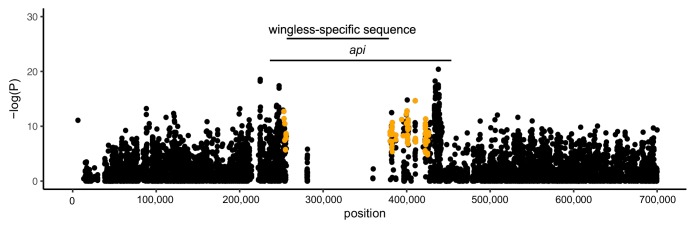
Association between SNPs at api and the male wing phenotype.Points show the association between SNPs and the male phenotype, illustrated as the -log(P) from a Fisher’s exact test between SNPs and the male wing phenotype using the alfalfa biotype pool-seq data. Orange points are SNPs that are perfectly segregating with the phenotype in the across-biotype data.